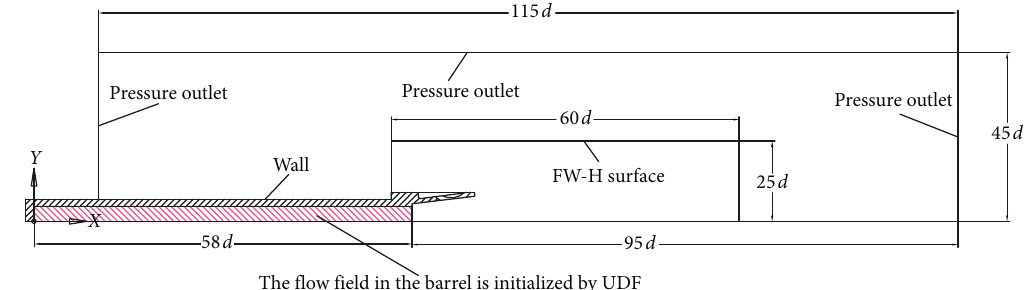
Figure 9: Schematic diagram of the computational domain and boundary condition.